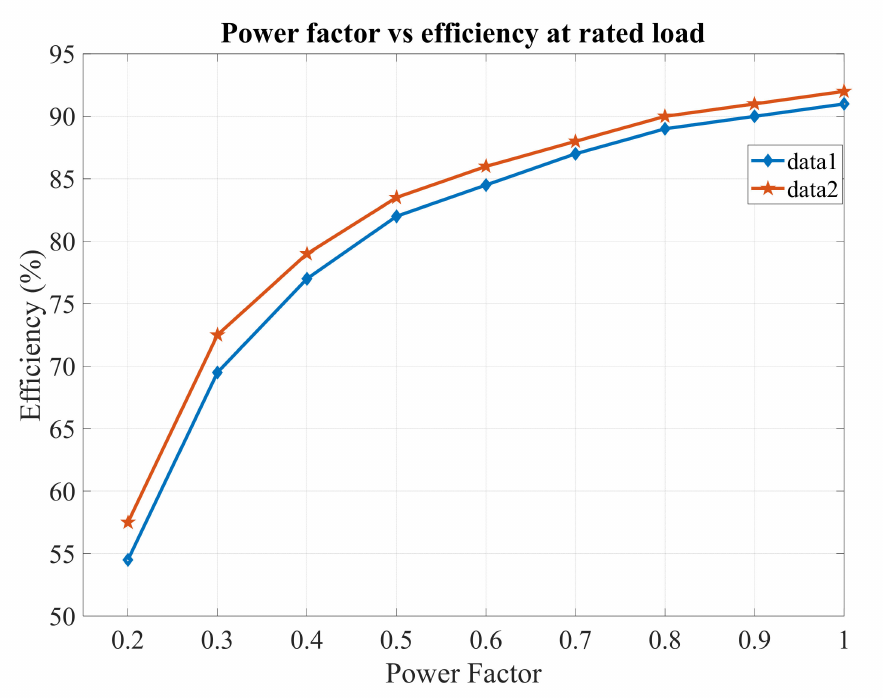
Figure 21. Efficiency comparison of a similar 3–7 phase transformer (data 1) vs. 3–3 phase transformer (data